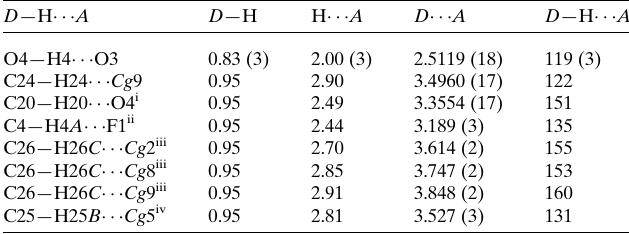
Table 1 Hydrogen-bond geometry (A˚ , (cid:3) ). Cg 2, Cg 5, Cg 8 and Cg 9 are the centroids of the rings (C1–C4,C9,C10), (C19– C24), (C1–C10) and (C1–C11,C18), respectively.